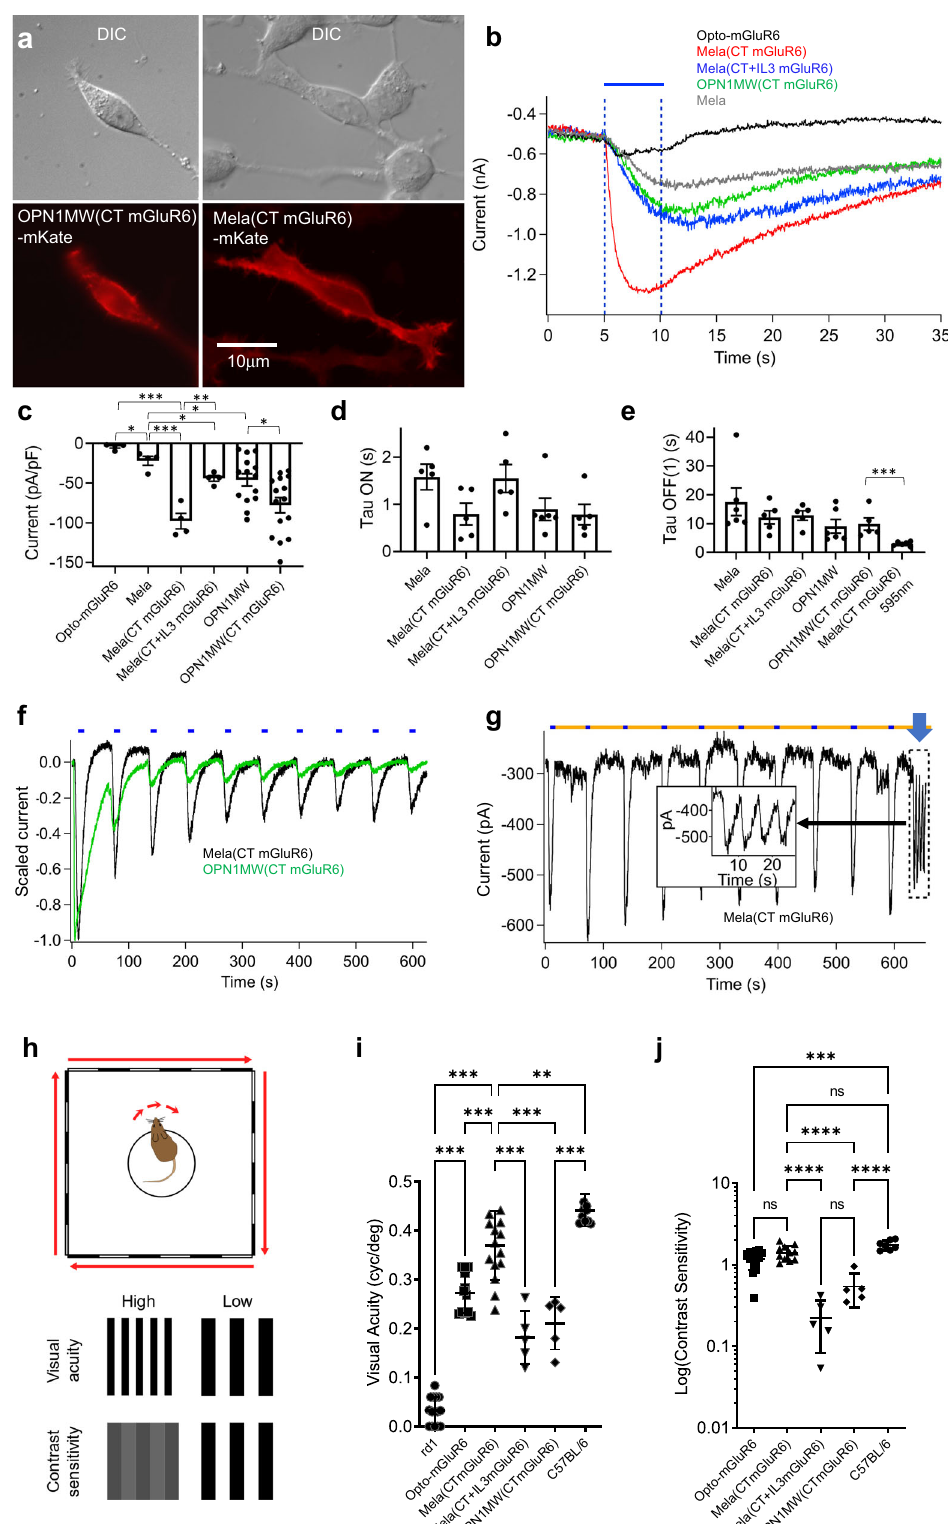
[Fig. 1e; Mela(CTmGluR6): 12.1 ± 2.3 s; n = 6; Mela(CT + IL3m- GluR6): 12.8 ± 1.7 s, n = 5; OPN1MW(CTmGluR6): 9.8 ± 2.2 s, n = 6; Mela WT: 17.6 ± 4.8 s, n = 6], providing evidence that melanopsin, without its regulatory C-terminus, is not inherently slow. Unlike native melanopsin, GIRK currents triggered by all chimeric constructs inactivated completely with a